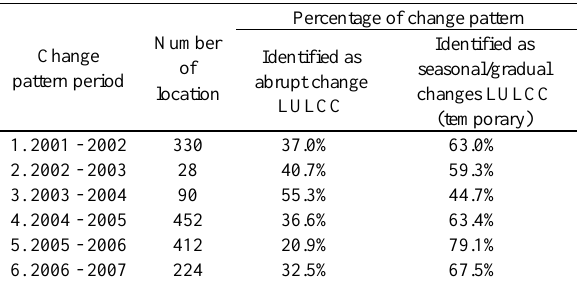
Table 1. The result of change detection for each period